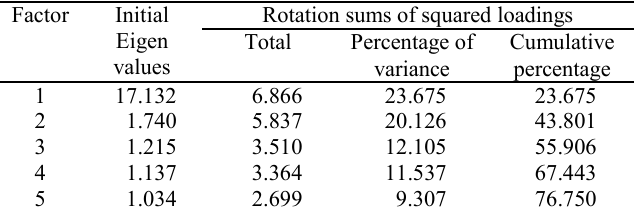
Table 2: Exploratory factor analysis